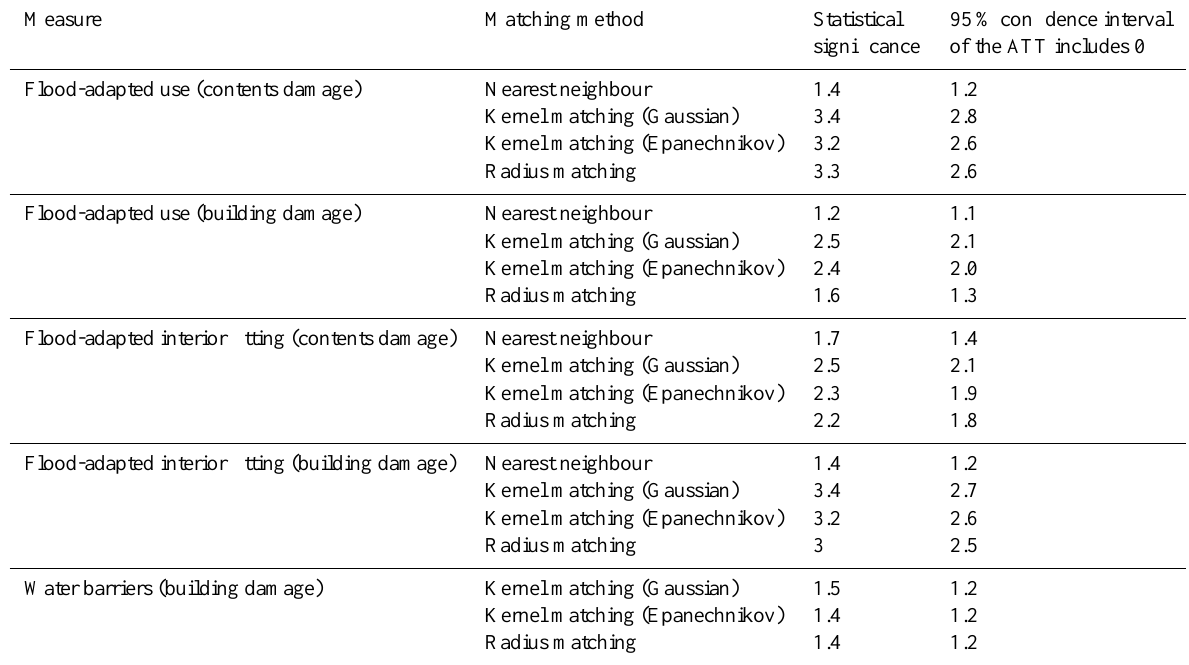
Table 3. Sensitivity analysis.